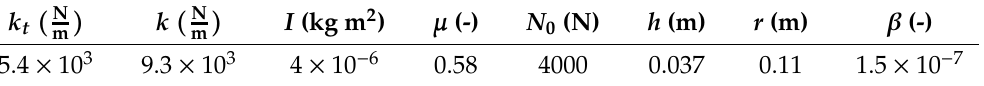
Table 1. Numerical values of 2 degrees of freedom (DoFs) model